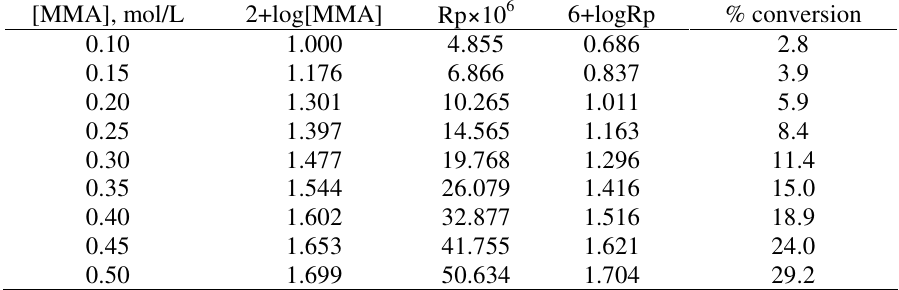
Table 1 . Dependence of rate on monomer